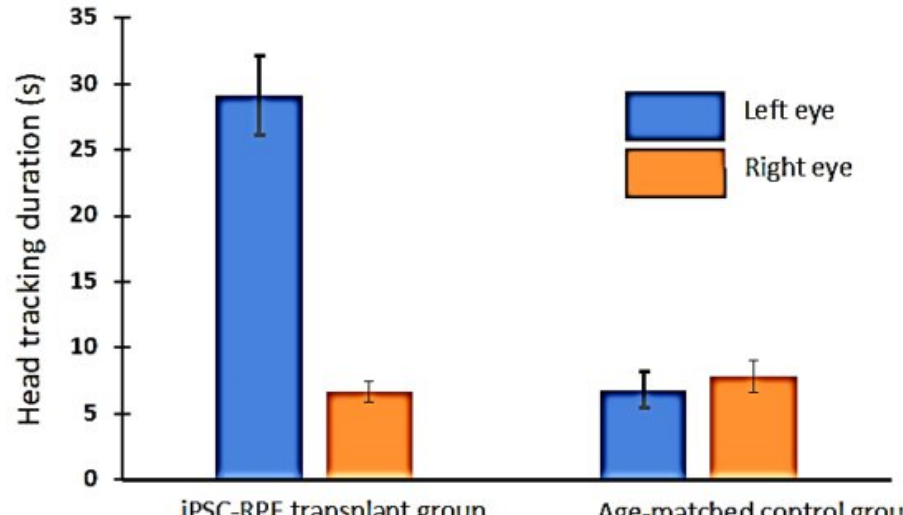
Figure 6. OKN testing data based on the duration of head-tracking recorded from 4-month-old immunodeficient RCS rats ( ± SE). The data show improved head-tracking response in the iPSC-RPE transplanted left eyes ( n = 12) compared to the non-transplanted eyes and age-matched control rats ( n =